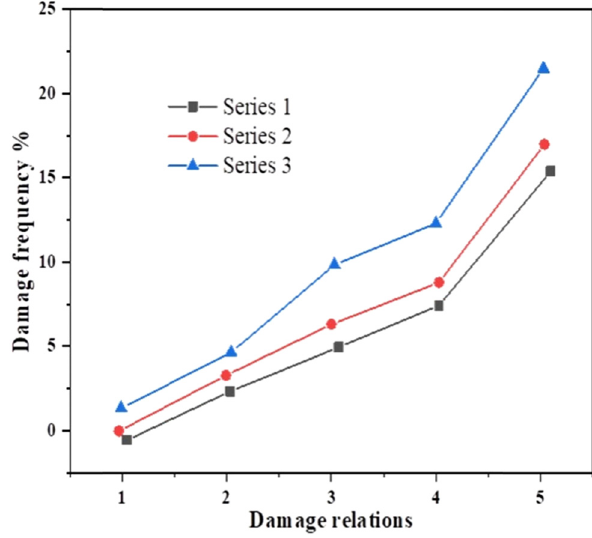
Figure 2: 450 mm Damage frequency and damage relationship